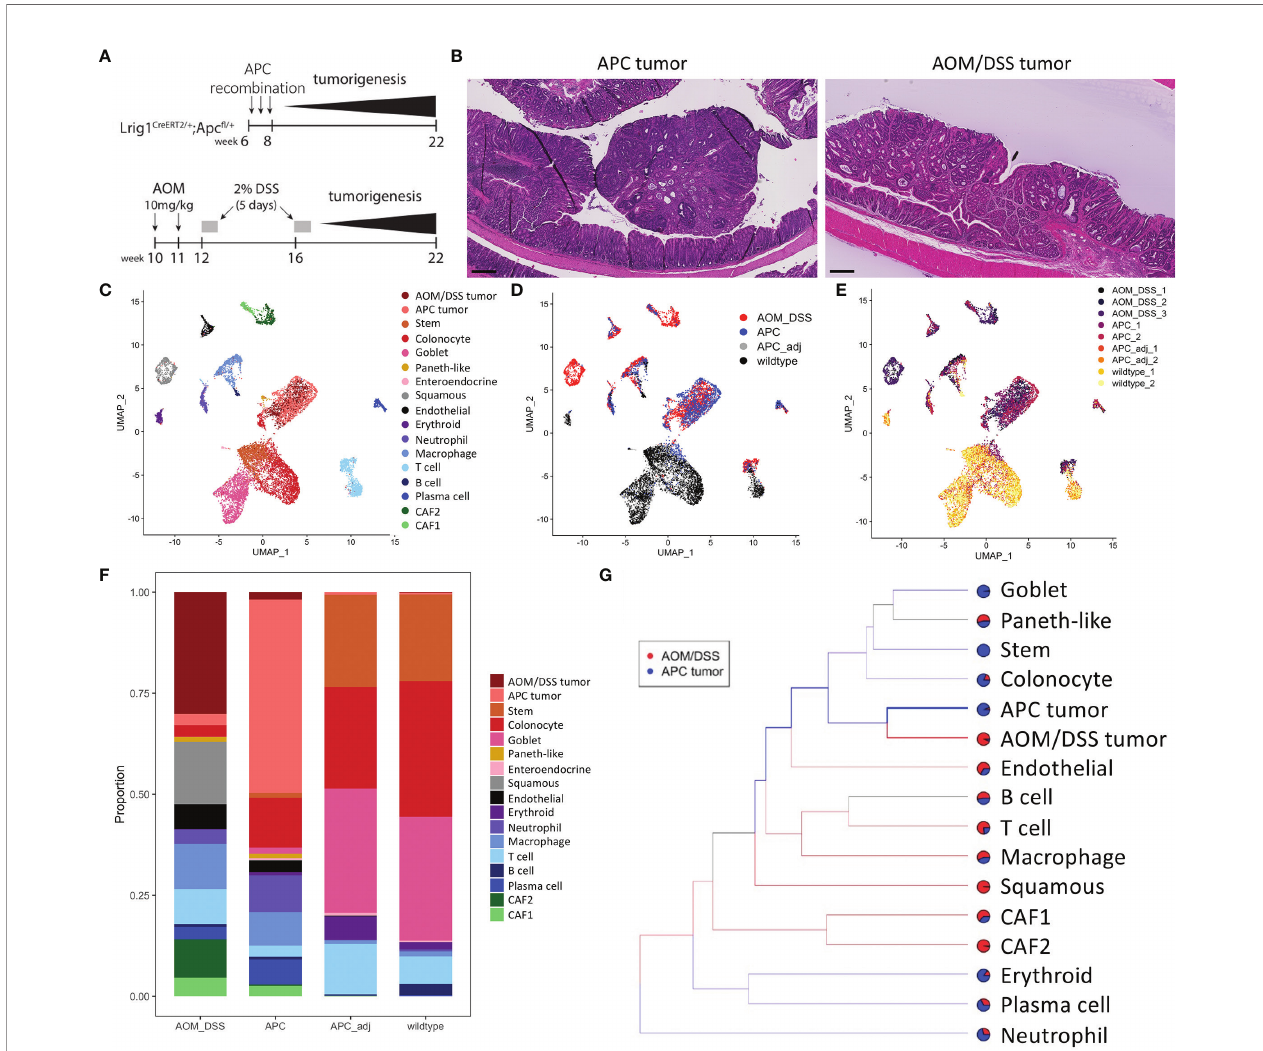
FIGURE 1 | Cell type composition of wildtype, APC tumor, APC adjacent normal, and AOM/DSS tumor samples assessed by scRNA-seq. (A) Experimental timeline for induction of APC tumors (top) and AOM/DSS tumors (bottom). (B) Representative H&E images of APC tumors and AOM/DSS tumors. Scale bars = 300 µm. UMAP co-embedding of wildtype, APC tumor, APC adjacent normal, and AOM/DSS tumor scRNA-seq samples with (C) cell type clustering overlay, (D) sample type overlay, and (E) replicate overlay, by color. (F) Bar graph of cell type proportions, broken down by sample type in scRNA-seq data. (G) sc-Unifrac analysis of APC tumor sample cell types compared to AOM/DSS tumor sample cell types from scRNA-seq data. Colored branches indicate statistically enriched cell population structures per sample type, with black branches indicating non-signi fi cance. Pie charts indicate the proportional representation between the two sample types. Thickness of branches represent level of enrichment sc-Unifrac distance values range from 0 to 1, with 0 representing complete overlap between two datasets sc- Unifrac distance =